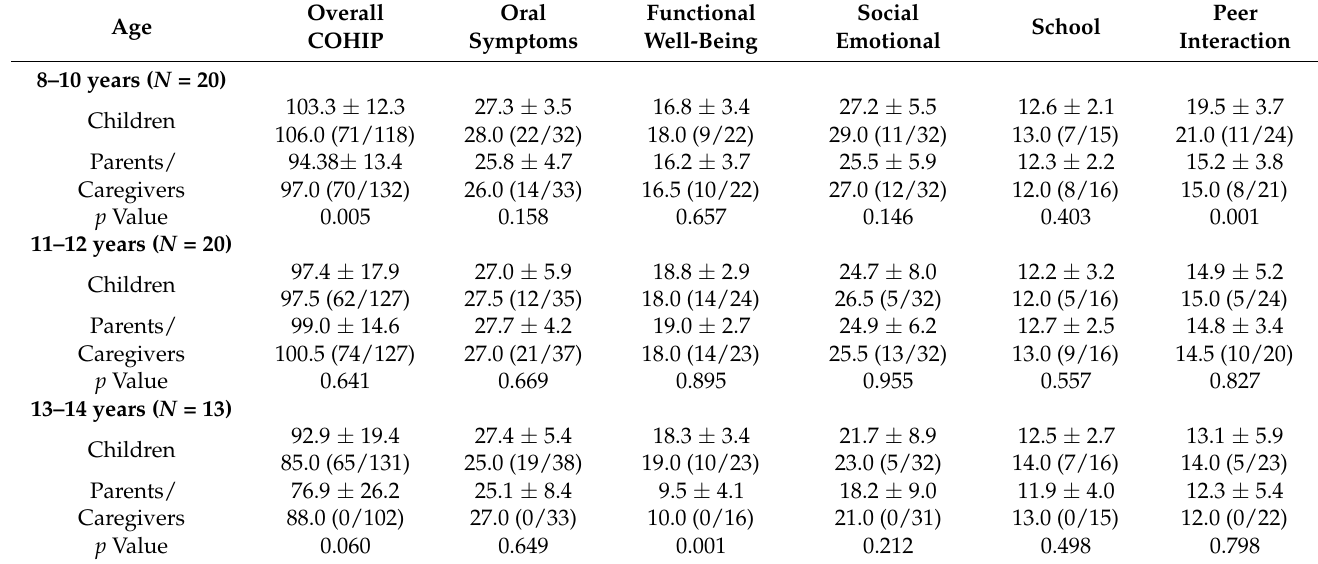
Table 5. Effect of children’s age on the agreement in COHIP overall and subscale scores between parents and cleft children [mean ± SD, median, (range)].